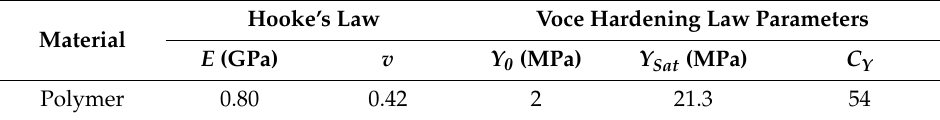
Table 2. Material parameters of the polymeric core of both composites ( E and ν are from [12]). Hooke’s Law Material